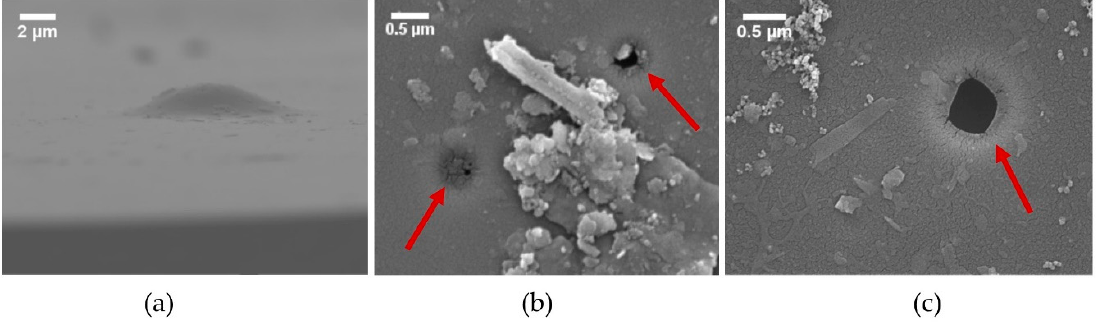
( c ) uncleaned coupon at 15.3 weeks. The arrows point to partially and newly exposed